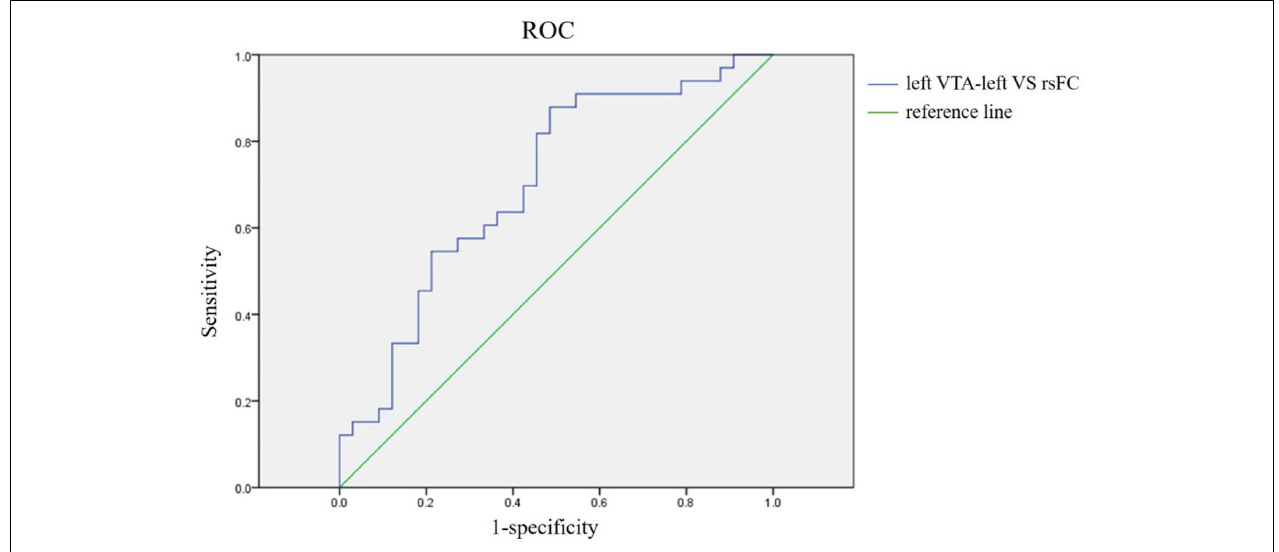
FIGURE 3 | Receiver operating characteristic analysis of the left VTA-left VS rsFC. Area under curve (AUC) representing the sensitivity to the discriminant tBD and UD, AUC = 70%. Sensitivity = 87.9%, Specificity = 51.5%, odds ratio = 7.703, P =